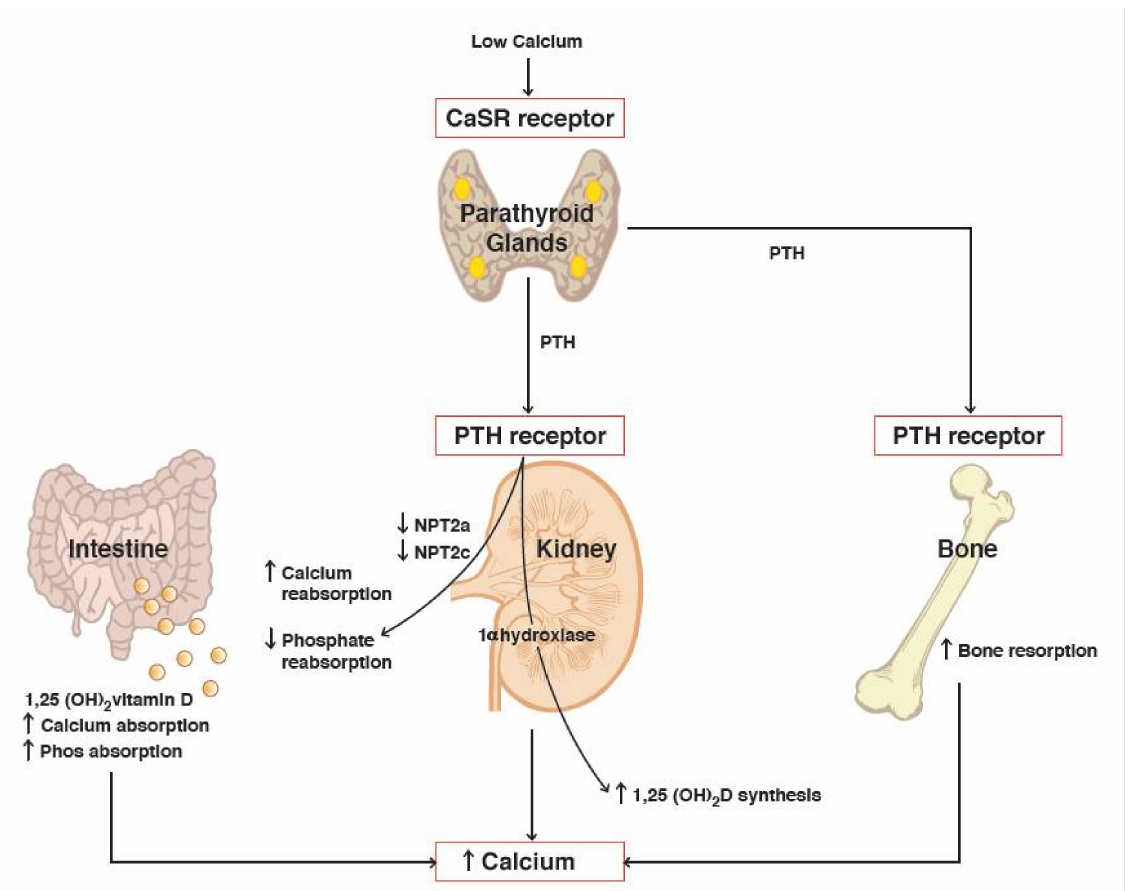
Figure 2. Regulation of calcium-phosphate homeostasis by the parathyroid glands, bone, kidneys, and intestinal tract. Low serum Ca 2+ stimulates PTH release and binding to receptors found on renal tubules and bone. Increased vitamin D1,25(OH) 2 synthesis also leads to increased intestinal absorption of calcium and phosphorus. CaSR = calcium sensing receptor, PTH = parathyroid hormone, 1,25(OH) 2 vitamin D = active form of vitamin D, NPT2a, NPT2c = sodium phosphorus